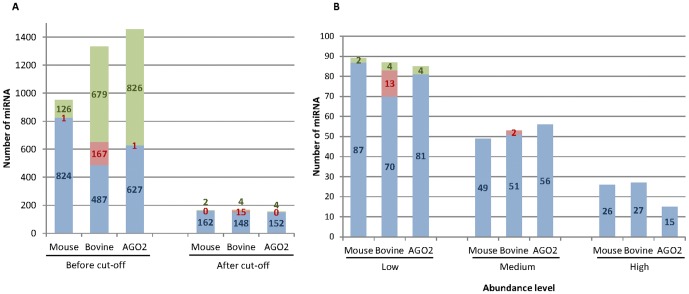
Characterisation of mouse and bovine lactating mammary gland libraries. A. miRNA identification in mouse and bovine lactating mammary glands.Unique sequences in mouse, bovine and AGO2-miRNomes were identified and classified in three categories according to their hits: (i) known miRNA in the species (blue), (ii) miRNA identified in other species (red) and (iii) predicted novel miRNA (green). Numbers of miRNA are presented before and after applying the 100 RPM cut-off point. B. Distribution of miRNA according to their abundance in mouse and bovine lactating mammary glands. The miRNA were classified in three categories: low, 100≤miRNA<1,000 RPM; medium, 1,000≤miRNA<10,000 RPM; and high, miRNA≥10,000 RPM.